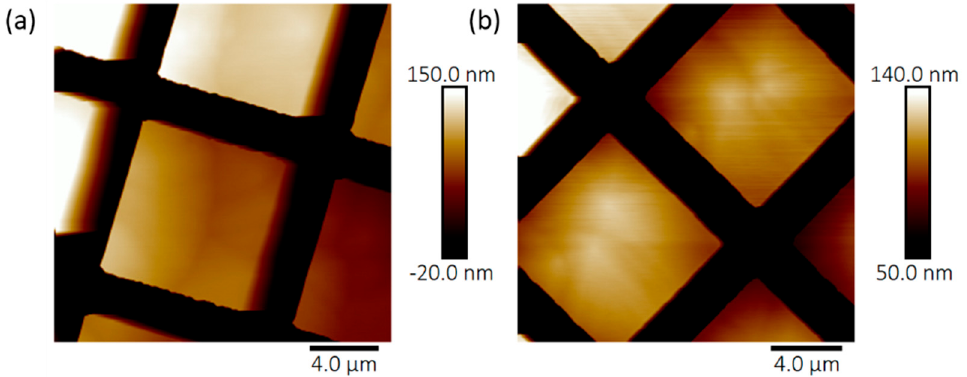
Figure 6. 20 × 20 µm 2 AFM height images of 1.3 µm AlGaN grown on 10 × 10 µm 2 tiles of compliant pseudo-substrate; with ( a ) x Al = 0.32 and ( b ) x Al = 0.50. The 2 µm spacing between the tiles was preserved.